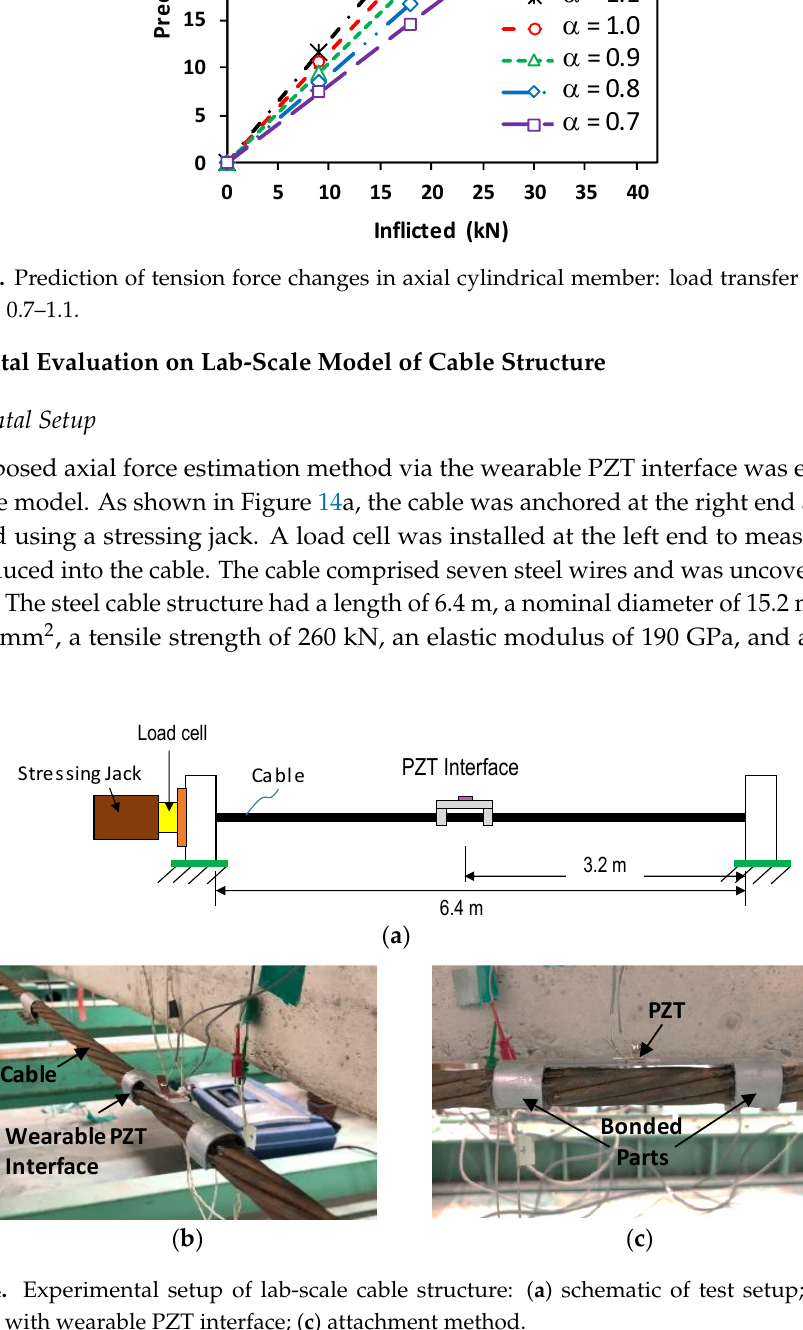
Figure 13. Prediction of tension force changes in axial cylindrical member: load transfer capability factor  = 0.7 – 1.1.